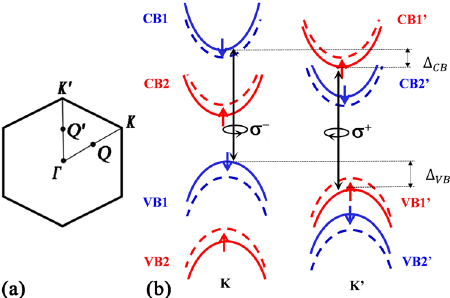
Fig. 3 Schematic diagrams of irreducible Brillouin zone and split of degeneracy at the KK ′ valleys of WSe 2 . a Irreducible Brillouin zone of WSe 2 . b Split of degeneracy at the KK ′ valleys. In ( b ), σ + and σ − denote the right-hand and left-hand circularly polarized light under optical selection rules at the KK ′ valleys. The dashed lines denote the B = 0 bands. Red and blue arrows denote spin up and spin down states, respectively. CB1 (CB2) and VB1 (VB2) denote the fi rst (second) conduction and valence bands at the K valley, while CB1 ′ (CB2 ′ ) and VB1 ′ (VB2 ′ ) denote the corresponding bands at the K ′ valley. Δ CB and Δ VB are the energy shifts of the conduction and valence band,